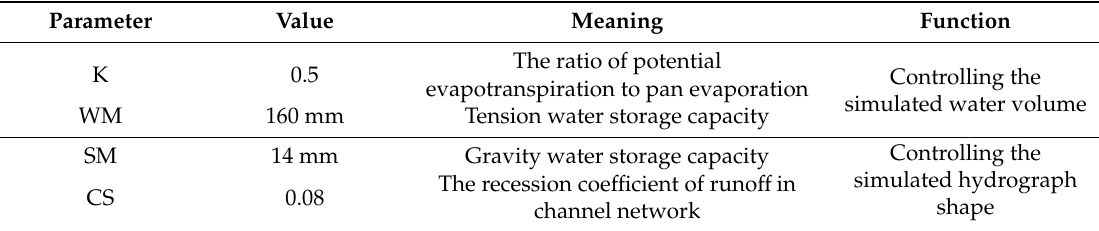
Table 6. The values and their functions of main parameters for the Xinanjiang model. Parameter Value Meaning